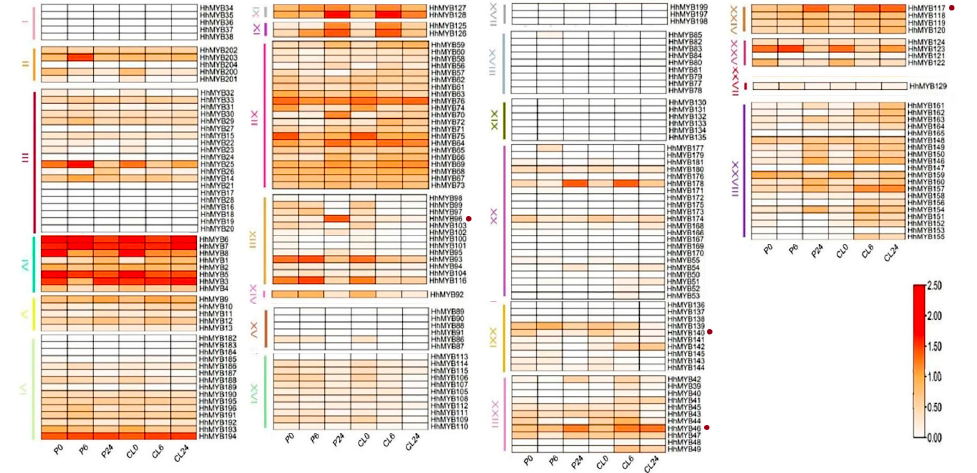
Figure 2. Expression pattern of MYB genes in H. hamabo under salt and drought stress as determined from RNA-Seq data. The expression level was represented by color: red, higher expression; white, lower expression. HhMYBs with a dot were specifically mentioned in the manuscript. P0, P6, P24, CL0, CL6, and CL24 represent treatments for 0 h, 6 h, and 24 h under PEG treatment and 0 h, 6 h, and 24 h under NaCl treatment, respectively.